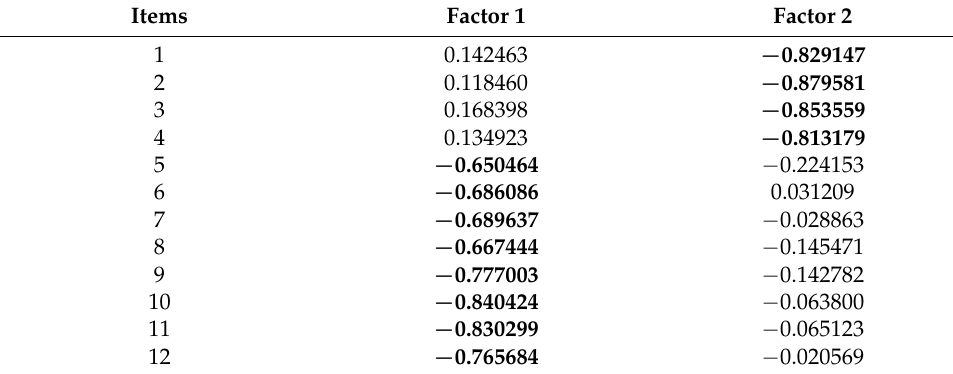
Table 2. Factor Loading—PCA ( n = 1227). Items Factor